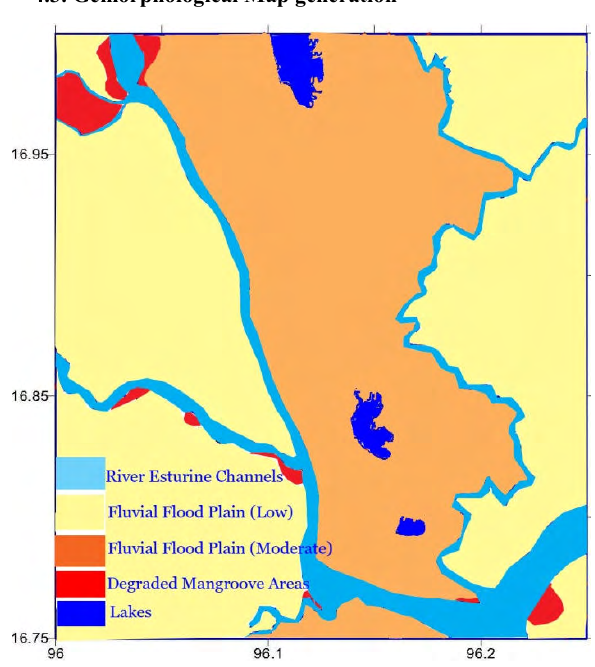
Figure 9. Geomorphological Map of Yangon river in and around